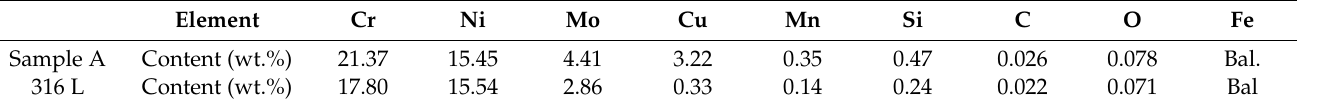
Table 1. Chemical composition of novel nitrogen-free austenitic stainless steel (022Cr21Ni15Mo4Cu3) and 316 L powders produced via gas